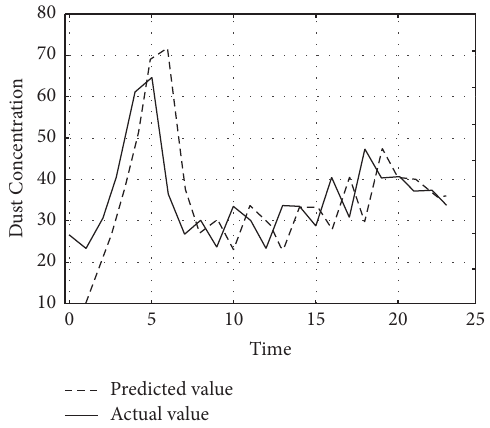
Figure 4: Forecasting results of the ARIMA model. Table 2: Prediction value of BP neural